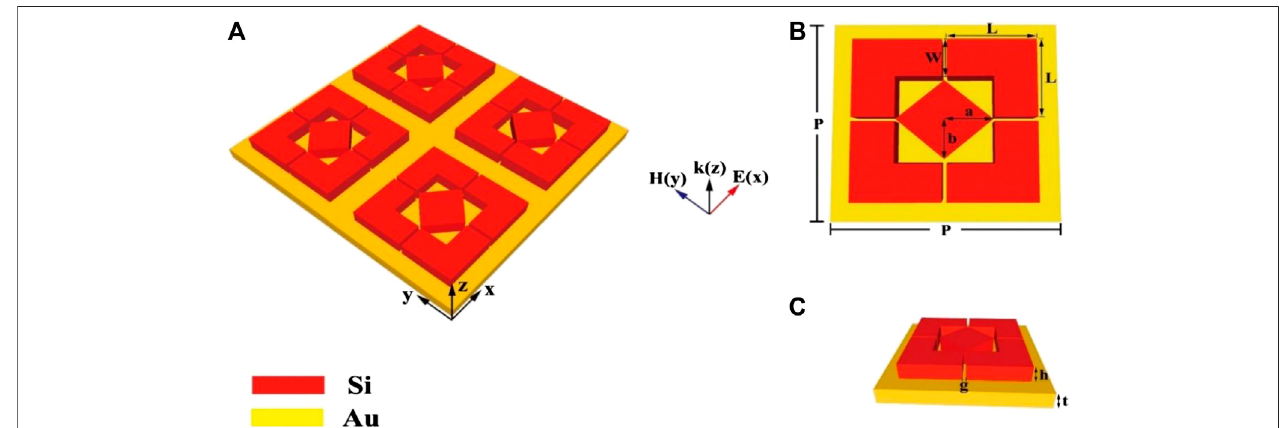
FIGURE 1 | (A) Perspective view of the MPA device structure. (B) Top view of the unit cell structure. (C) Side view of the unit cell structure.